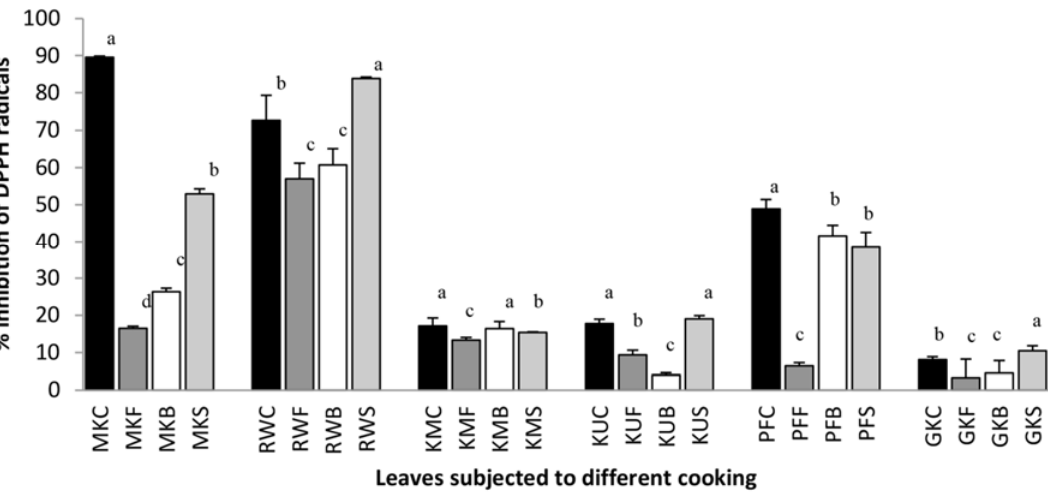
Figure 5. 2,2-diphenyl-1-picrylhydrazyl (DPPH) free radical scavenging ability of raw and cooked extracts of some green leafy vegetables. Values represent the means of triplicate readings. MK, O. zeylanica ; RW, C. auriculata ; KM, S. grandiflora ; KU, G. lactiferum ; PF, P. edulis ; GK, C. asiatica . C—fresh leaves; F—fried; B—boiled; S—steamed. Data are means ± standard deviations of three replicate determinations. Columns with different letters for each vegetable are significantly different ( p < 0.05).